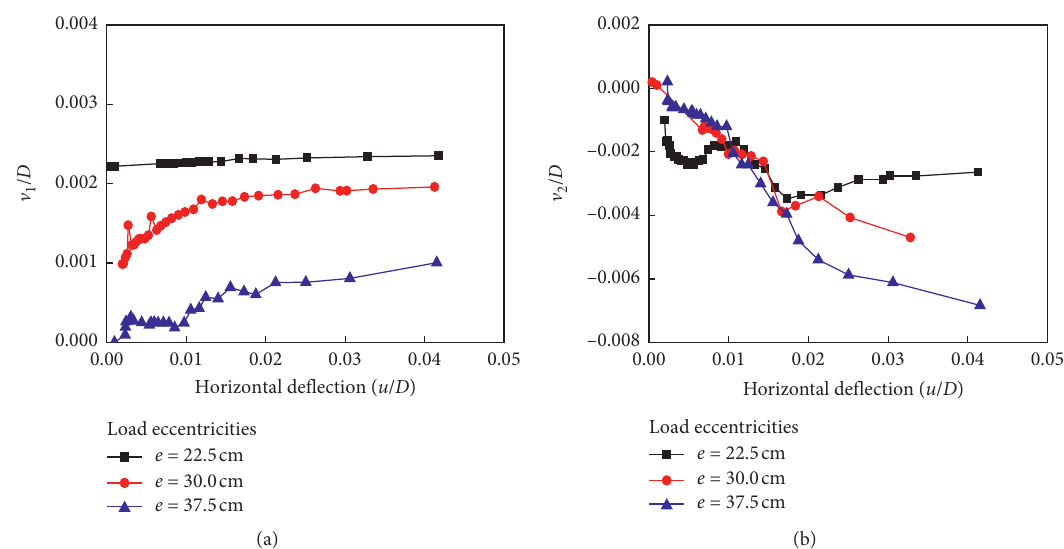
Figure 10: Vertical displacement of the CHFRF no. II-D under lateral loading. (a) For the distribution of v